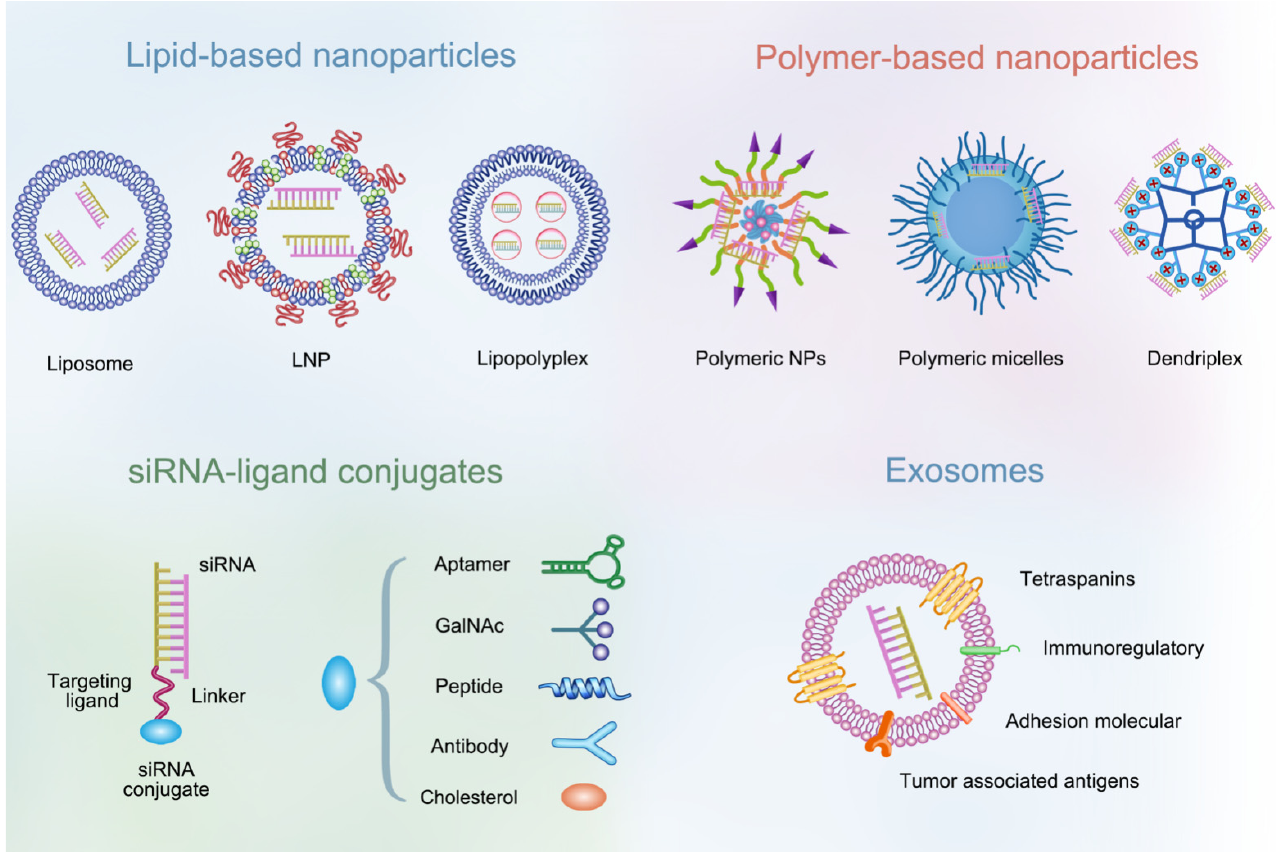
Figure 2. Schematic diagram of non-viral strategies to improve siRNA delivery. The most commonly used delivery systems include lipid-based nanoparticles (liposome, LNP and lipopolyplex), polymer-based nanoparticles (polymeric nanoparticles, polymeric micelles and dendritic polymers), siRNA-ligand conjugates and exosomes. Table 2. siRNA-based cancer therapeutics in clinical trials.